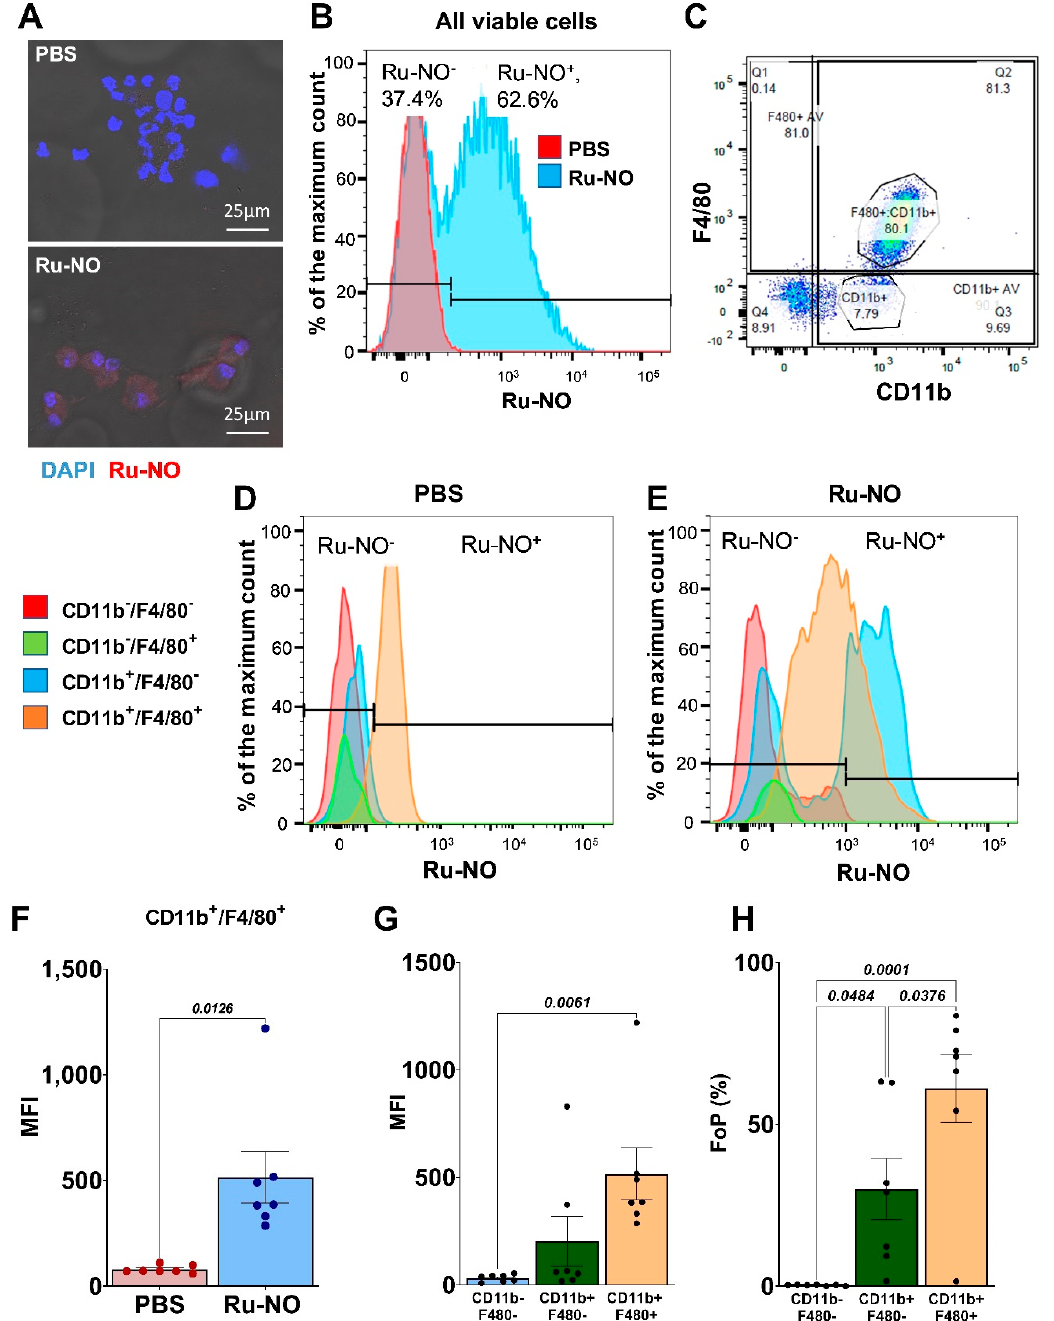
Figure 3. Ru-NO uptake and detection in peritoneal macrophages ( A ) Representative confocal microscopy images of Ru-NO intracellular fluorescence signal in peritoneal cells 24 h following intraperitoneal injection of PBS (top) and 40 µM Ru-NO (bottom). ( B ) Representative flow cytometry histograms of peritoneal lavage cells following intraperitoneal infusion of PBS and Ru-NO. ( C ) Representative plot of the distribution of cells with F4/80 and CD11b markers. Representative flow cytometry histograms identifying four populations based on F4/80 and CD11b markers and sensor uptake in ( D ) PBS and ( E ). Ru-NO exposed peritoneal lavage cells. ( F ) Mean fluorescence intensity (MFI) of PBS and Ru-NO exposed CD11b + F4/80 + peritoneal lavage cells. ( G ) MFI and ( H ) frequency of parental (FoP) analyses of Ru-NO fluorescence in non-myeloid cells (CD11b − F4/80 − ), myeloid cells (CD11b + F4/80 − ) and macrophages (CD11b + F4/80 + ). Mean ± SEM, p values derived from a t test or one-way ANOVA with Tukey post-hoc test (n = 7 repeated experiments).